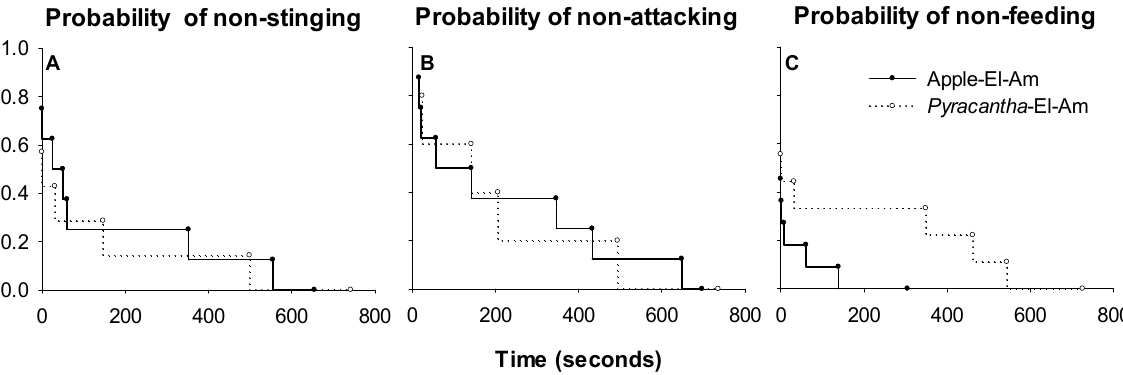
Figure 3. Survival tests to evaluate the probability of non-stinging ( A ), non-attacking ( B ) and non-feeding ( C ) by the parasitoid A. mali from different aphid host origins (apple trees or Pyracantha coccinea ).